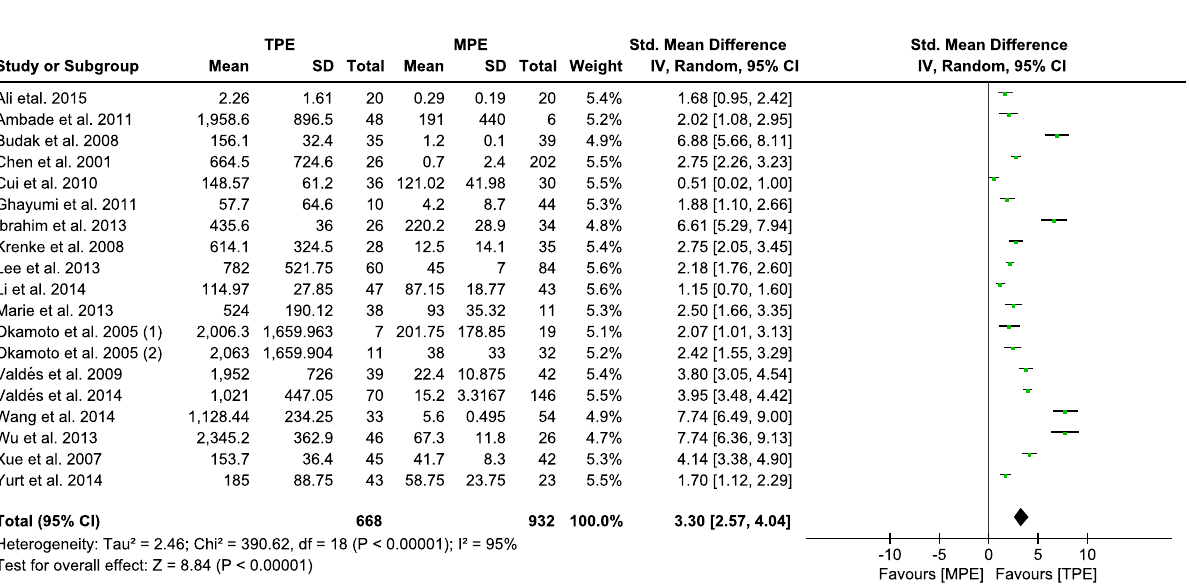
Figure 3. Forest plot of 19 studies comparing IFN-γ levels in TPE and MPE subjects. The standardized mean difference (the pleural fluid levels of IFN-γ in TPE subjects minus that in MPE subjects) was estimated by meta-